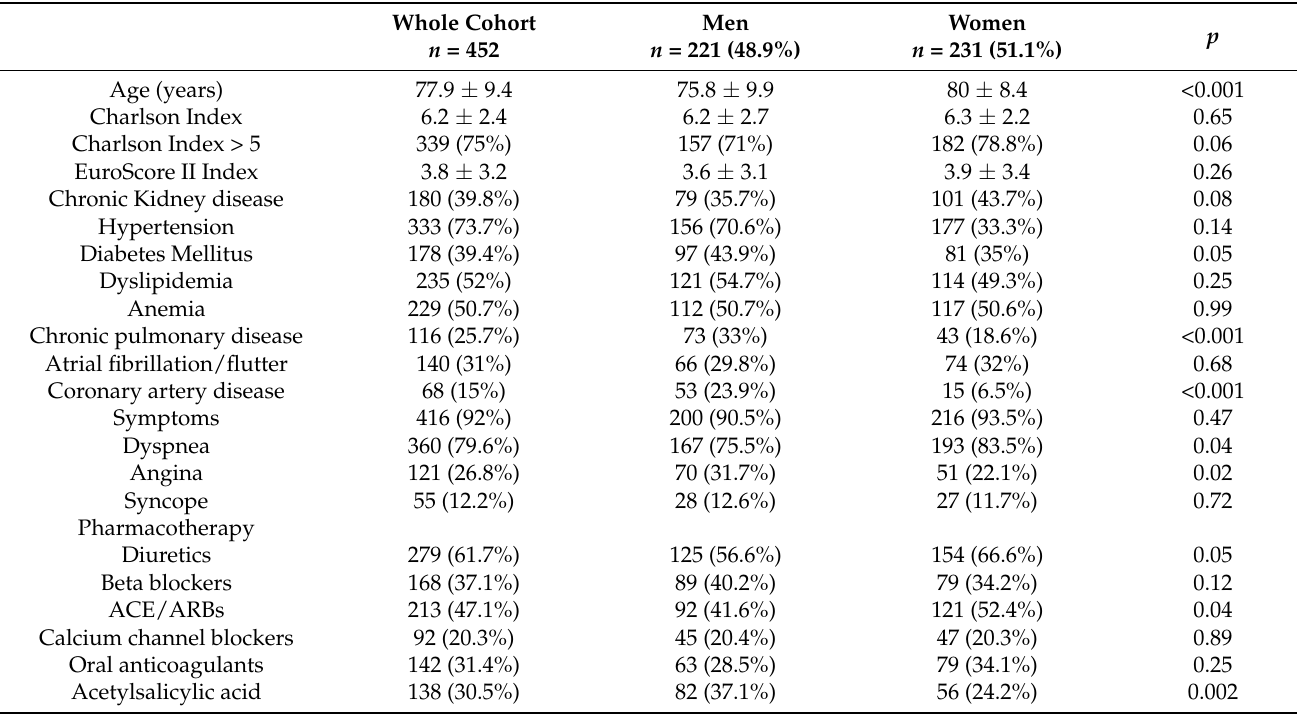
Table 1. Baseline clinical data.